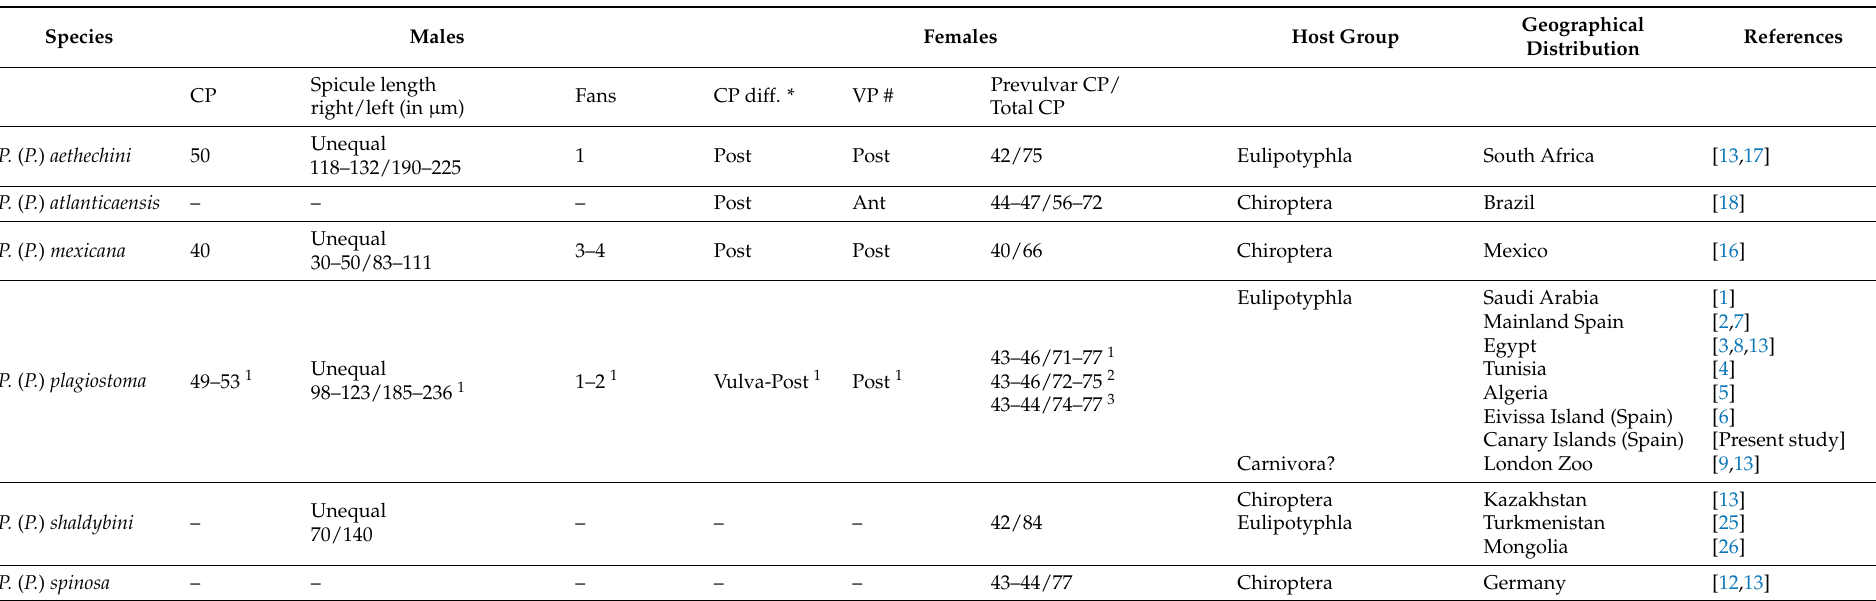
Table 1. Main morphological characteristics, host group, and geographical distribution of the species of the subgenus Pterygodermatites ( Pterygodermatites ) Quentin,